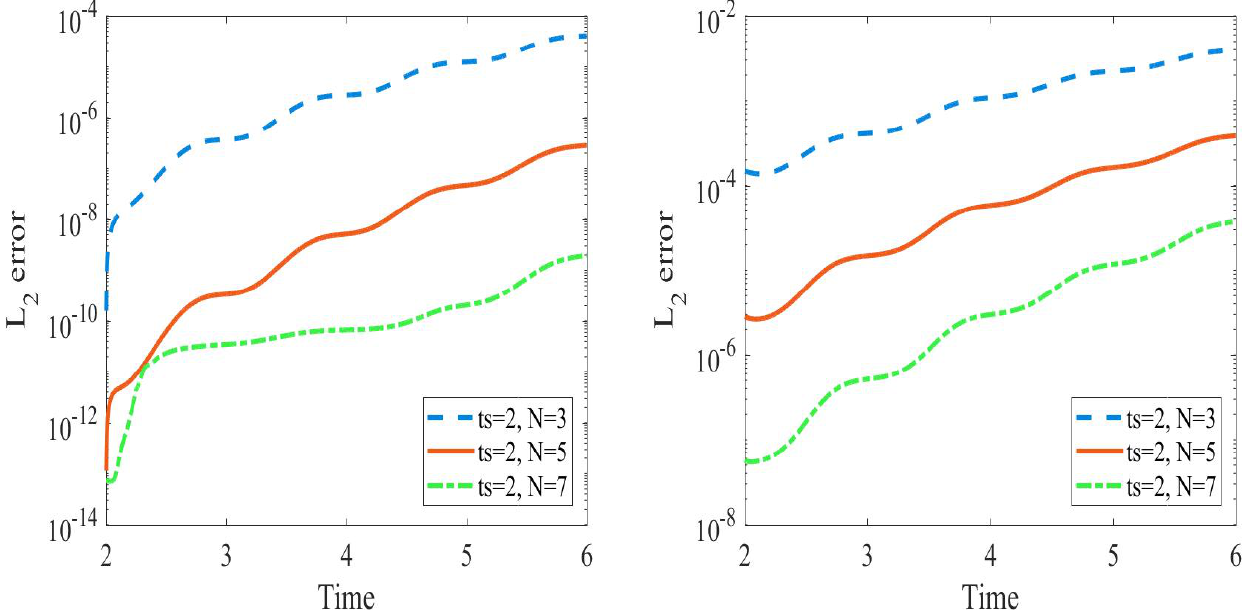
and the and the   =    =